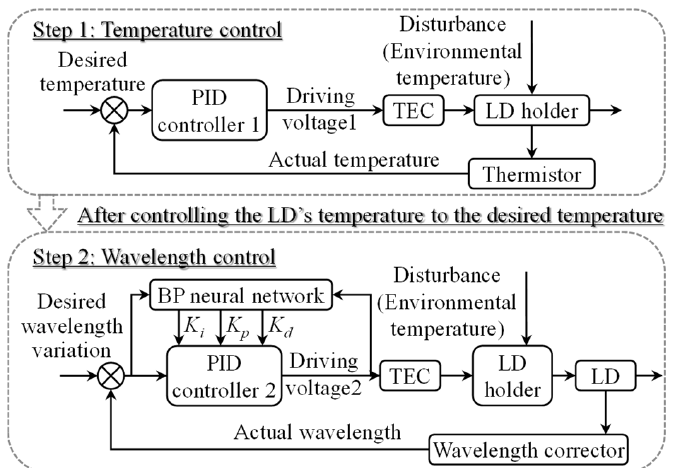
Figure 5. Corrected signals: ( a ) sinusoidal and cosine signals and ( b ) Lissajous figure.